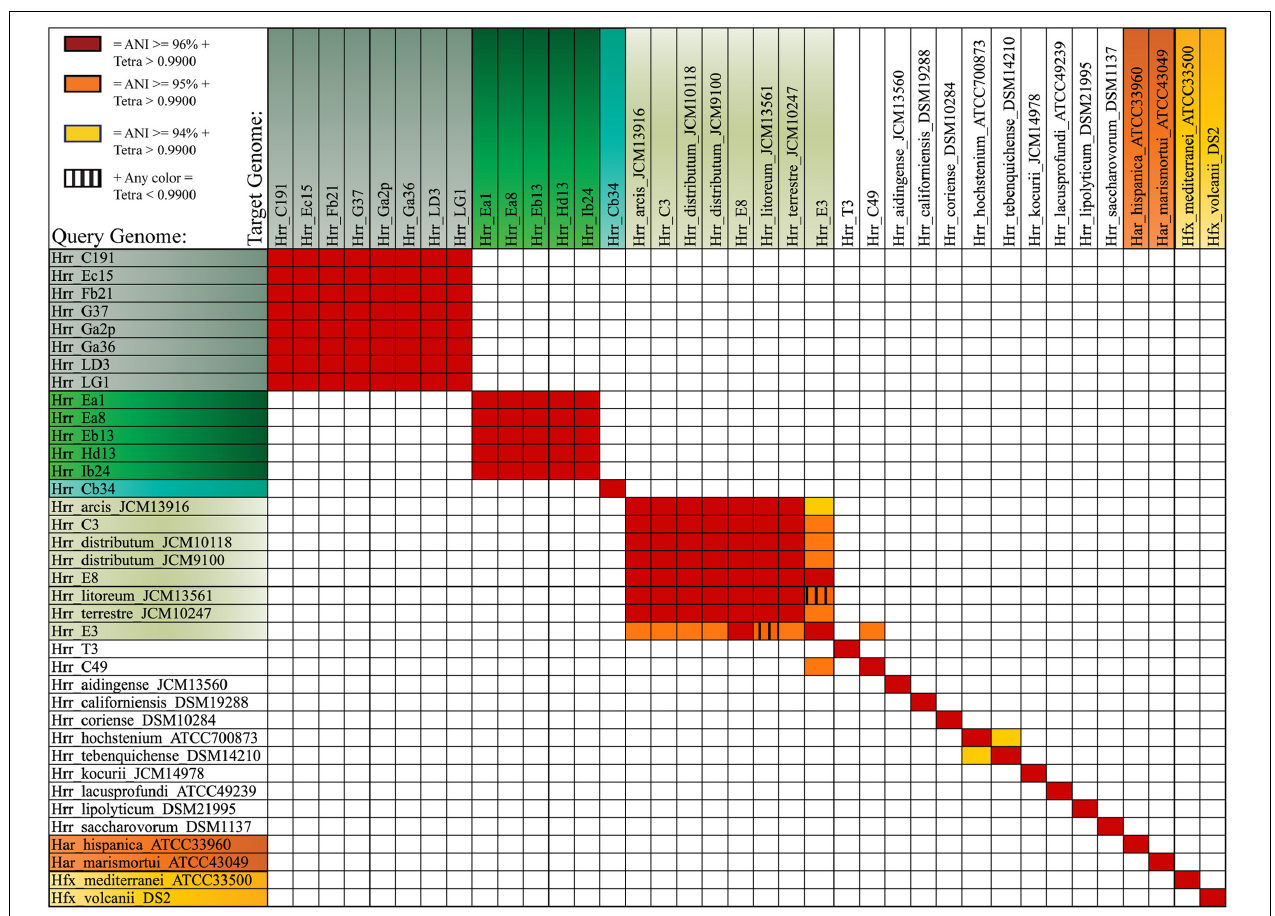
greater, Orange 95% or greater, and yellow represents 94% or greater. The vertical stripes indicate tetramer regression coefficients lower than 0.9900.